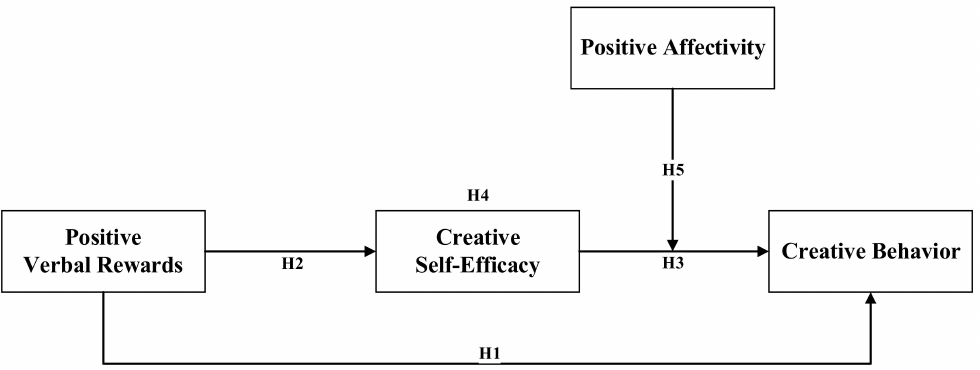
Figure 1. Research model for analyzing the occurrence of creative behaviors among cultural innova- tion team members from the perspective of positive verbal